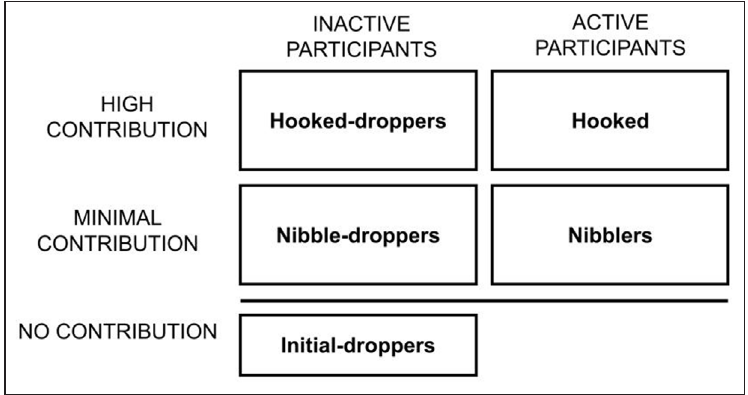
Figure 1 A grid outlining the categories within the Nibble-and-Drop Framework. What we call initial droppers are people who make no contributions to a program after signing up to participate. The other four categories are at the various intersections of participation rates and recency. Participants who remain active are either hooked or nibbling, depending on how much they contribute. Participants who are no longer active are either hooked-droppers or nibble-droppers, depending on how much they contributed.